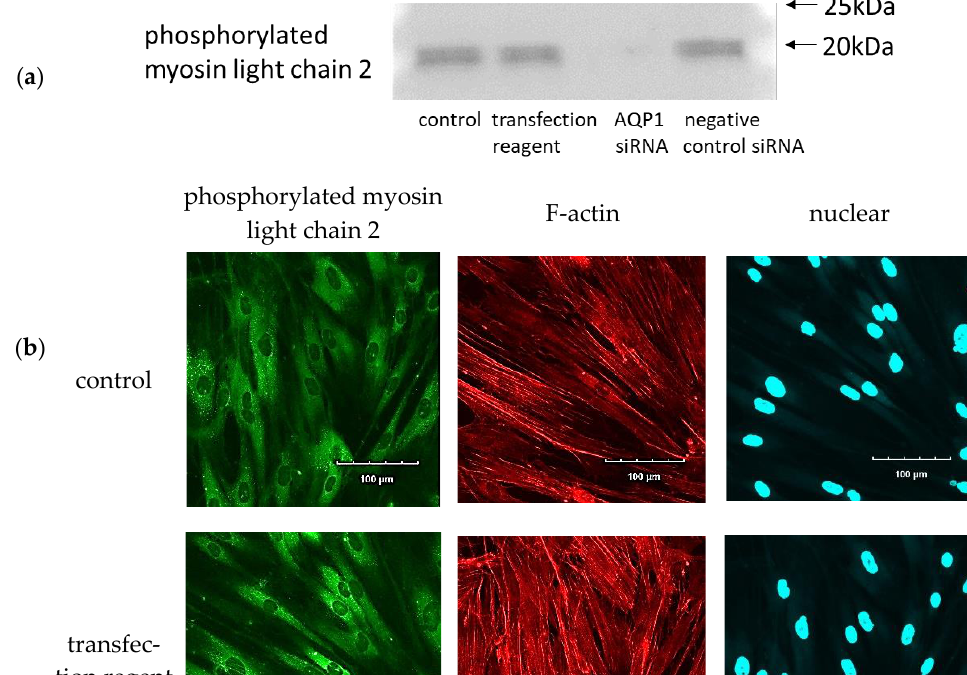
8 of 16 ( c ) Figure 3. Collagen gel contraction of cultured human dermal fibroblasts. ( a ) Images of collagen gel before and after 5 days of culture. ( b ) Area of collagen gel after 5 days of culture. **: p < 0.01 vs. the transfection reagent. The figures show the means ± standard deviations ( n = 3). ( c ) Relative cell count after 5 days of culture. 3.4. Amount of Staining of Phosphorylated Myosin Light Chain 2 and F-Actin in Human Dermal Fibroblasts in which AQP1 was Depleted by AQP1 siRNA Human dermal fibroblasts were cultured in untreated medium (control), medium with the transfection reagent, or medium with AQP1 siRNA for 3 days. Human dermal fibroblasts cultured with AQP1 siRNA showed lower amounts of both phosphorylated myosin light chain 2 and F-actin than those cultured in the control medium, those cultured in medium with the transfection reagent, or those cultured in the negative control siRNA (Figure 4a). Figure 4b shows the images of cultured human dermal fibroblasts stained with the anti-phosphorylated myosin light chain 2 antibody and phalloidin-iFluor 555